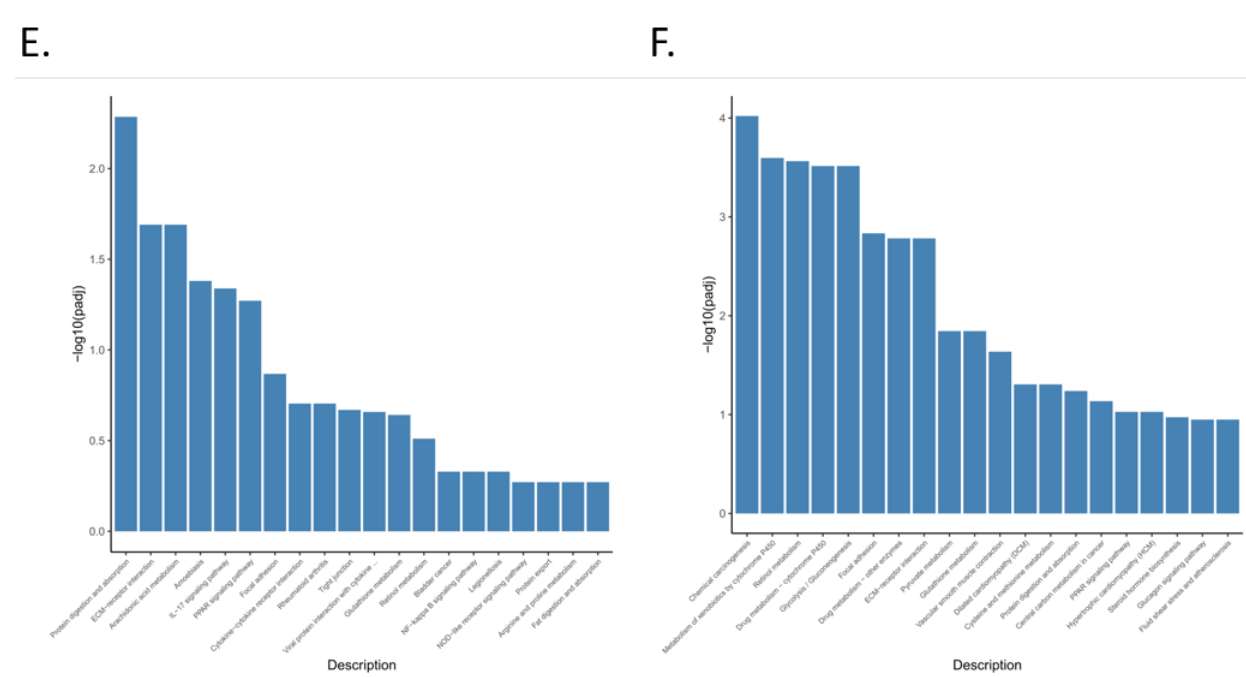
Figure 5. KEGG pathway enrichment analysis of DEGs in different comparison groups. S_Z vs. S_B ( A ), K_Z vs. K_B ( B ),